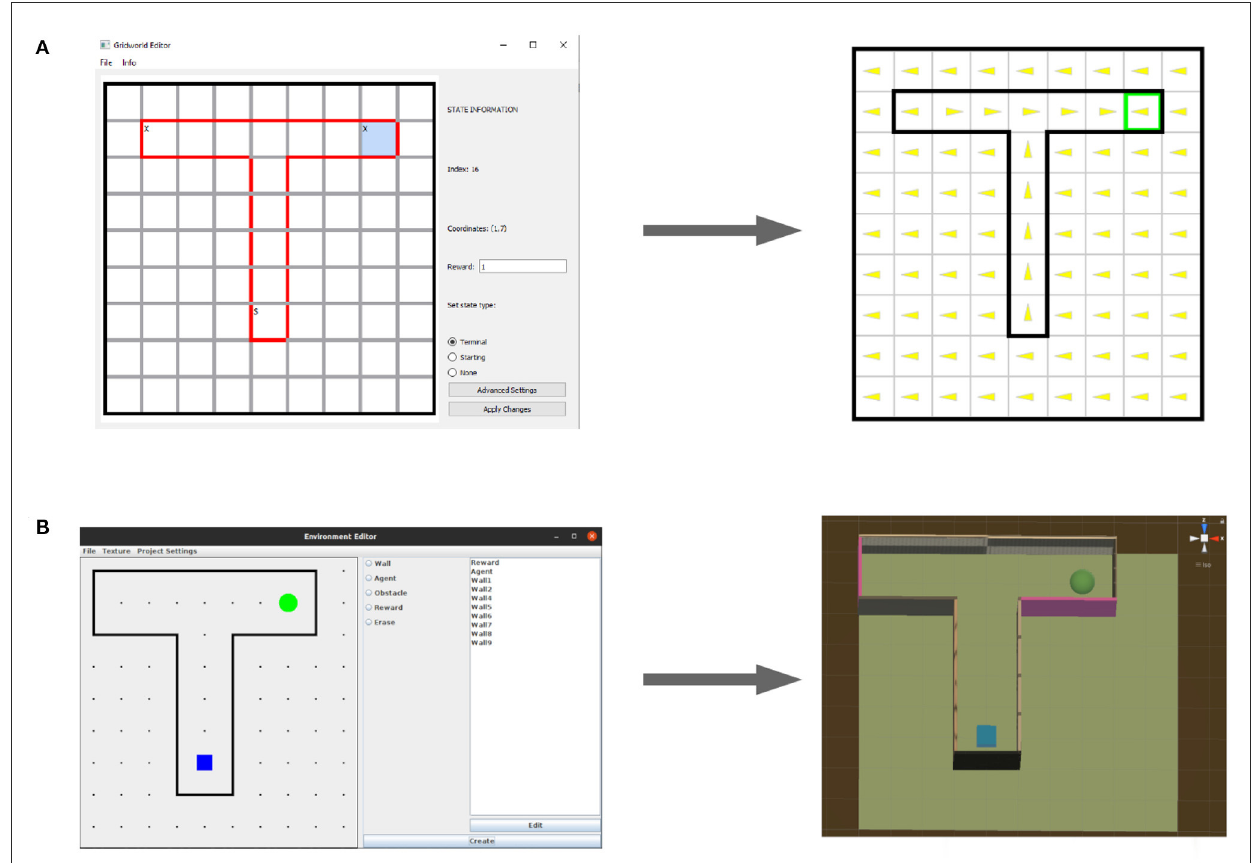
FIGURE3 World editors. (A) The gridworld editor (left) can be used to quickly and intuitively create new environments for simulation (right). (B) The editor for 3D Unity environments (left) generates 3D Unity scenes (right).